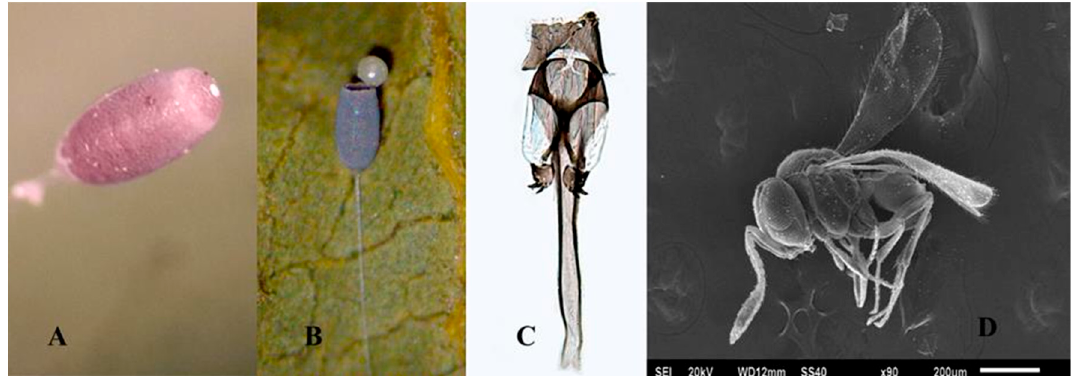
Figure 2. (A ) Egg parasitized by Telenomus lobatus , ( B ) Chorion of Chrysopidae abandoned by Te . lobatus , ( C ) Male genitalia, ( D ) Female Te . lobatus